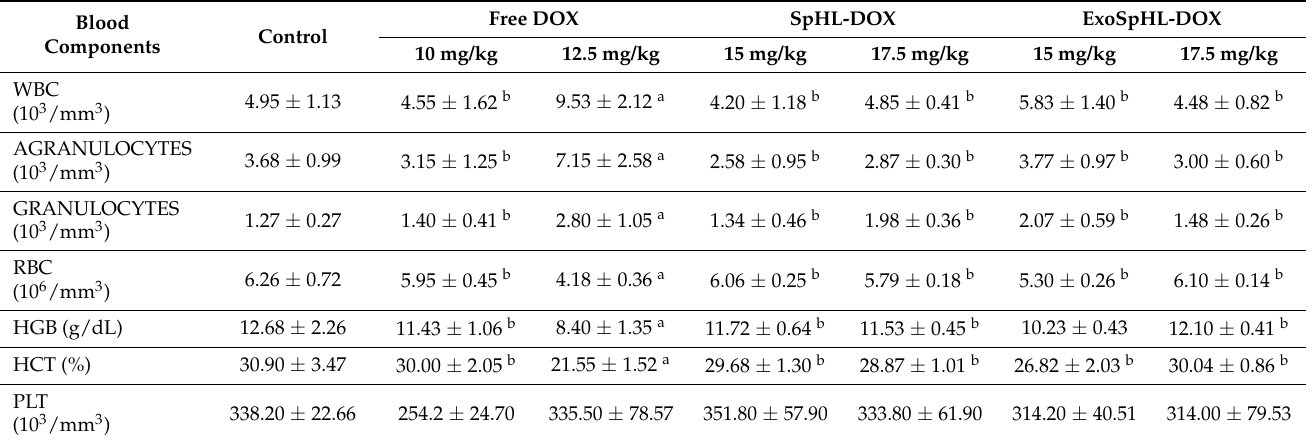
Table 1. Hematological parameters for healthy Balb/c mice treated with different doses of free DOX, SpHL-DOX, or